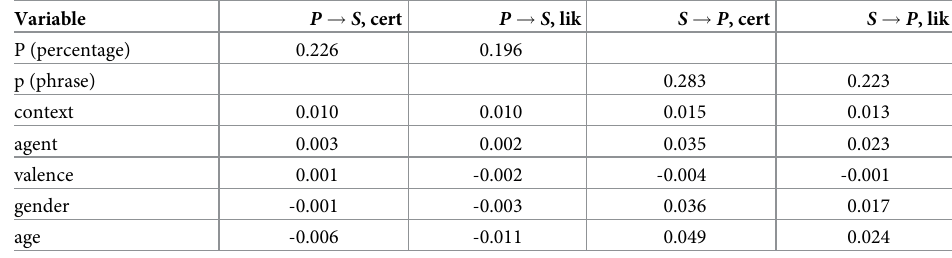
Table 1. Importance scores of random forest variables evaluated as mean change in accuracy, conditional on the variables already included in the model (in order from top to bottom). Higher values correspond to more impor- tant/influential variables. Here, P refers to percentage and p to the